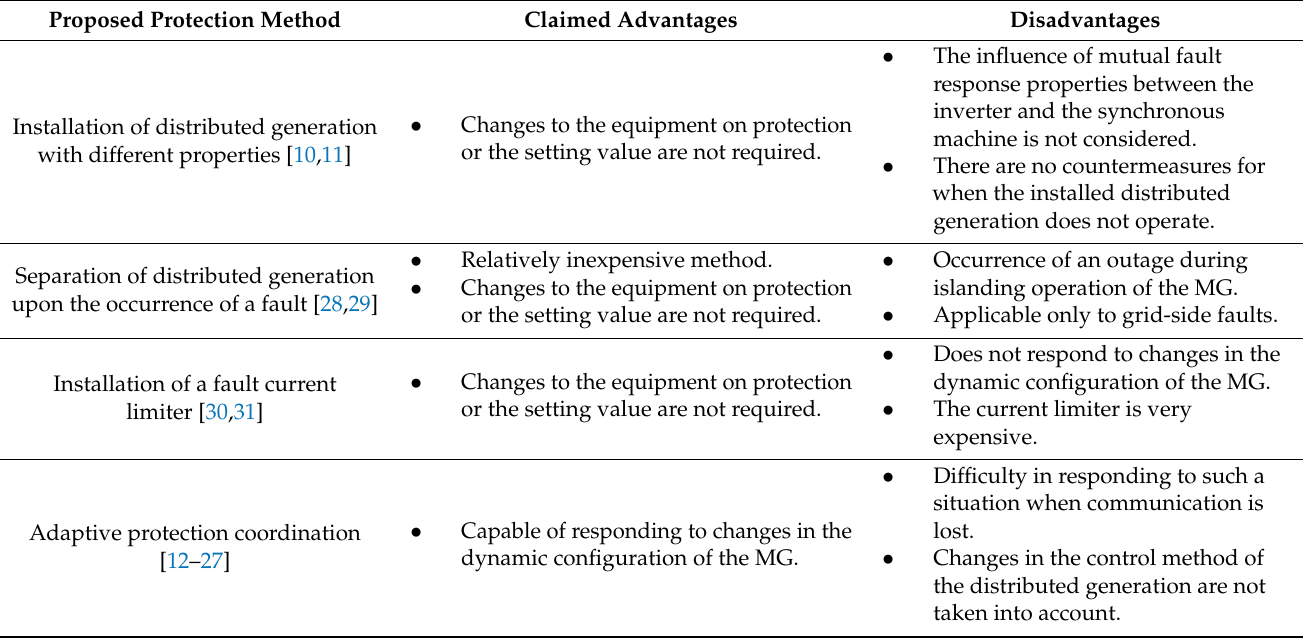
Table 1. Comparative summary of the proposed solution for microgrid protection